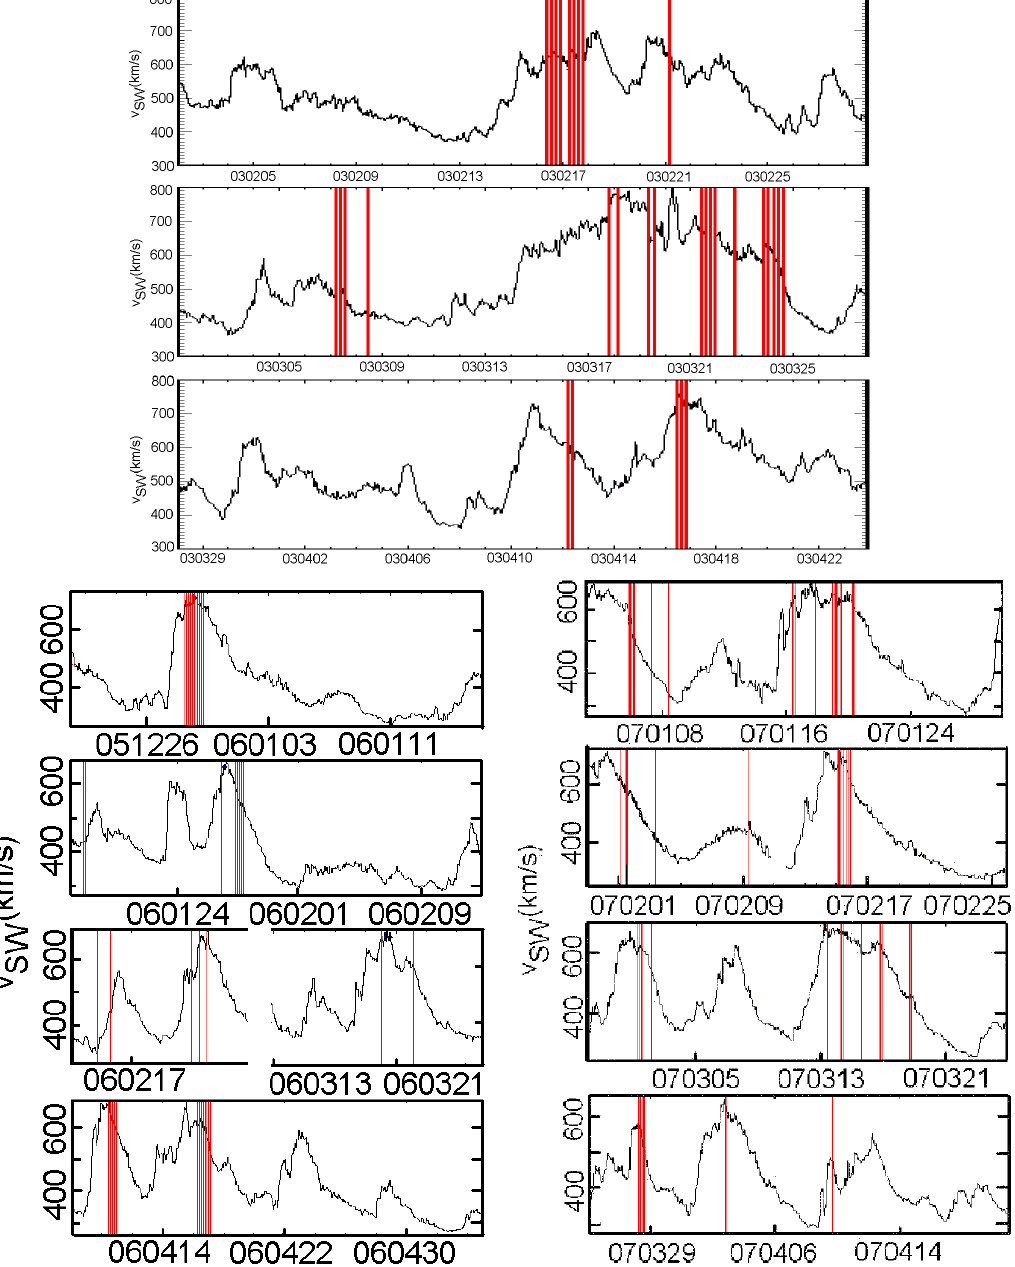
Fig. 10. 1h averaged solar wind speed; the vertical red lines give the time of HFAs. The top, bottom left and right figures were measured by ACE SWEPAM instrument in 2003, 2006 and 2007, respectively. The connection between the fast solar wind regions and the HFAs is